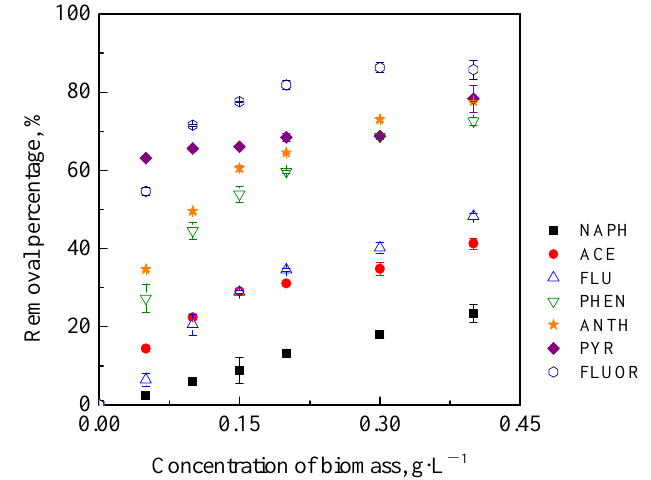
Figure 3. Effects of the biosorbent dosage on the biosorption removal of PAHs.